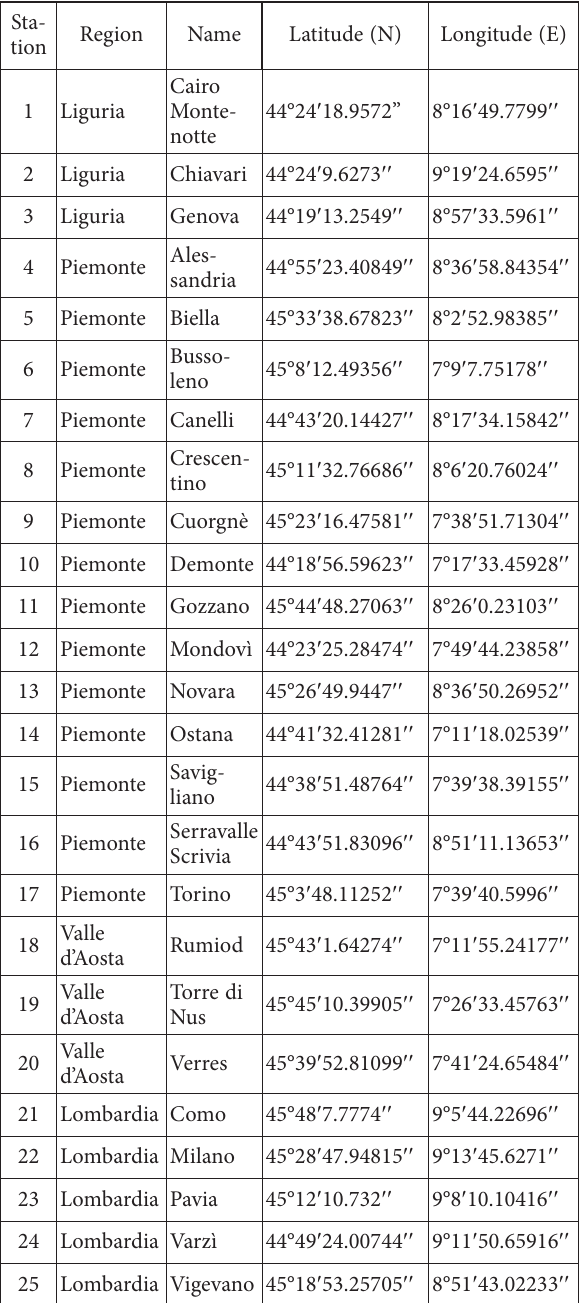
Table 1. The GNSS (Global Navigation Satellite System) Permanent Stations (PS) considered: Italian region, station name, horizontal coordinates (latitude and longitude) are